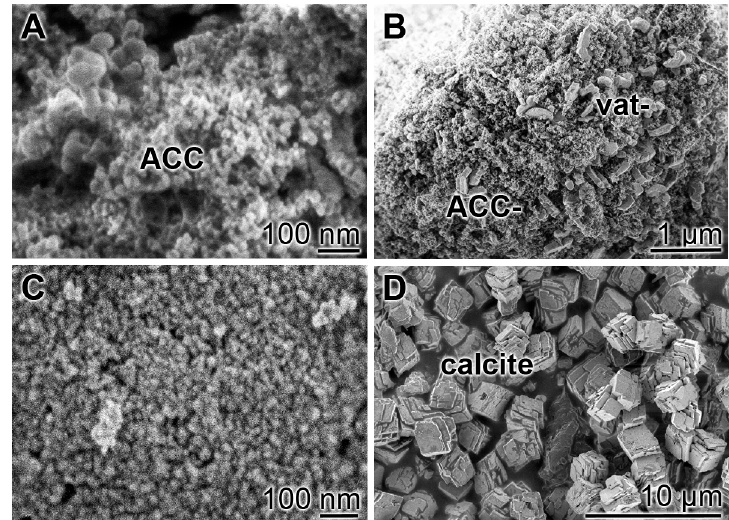
Figure 1. Morphology of amorphous CaCO 3 nanoparticles (ACC-NP) versus calcite crystals; SEM. The ACC-NP were used for microscopic inspection either ( A ) immediately after precipitation or ( B ) after an aging period of 3 h or after 3 days. ( C , D ) In parallel, CaCO 3 was directly prepared in the absence of polyP; then calcite is formed. Amorphous CaCO 3 (ACC), vaterite (vat) and calcite particles are marked.